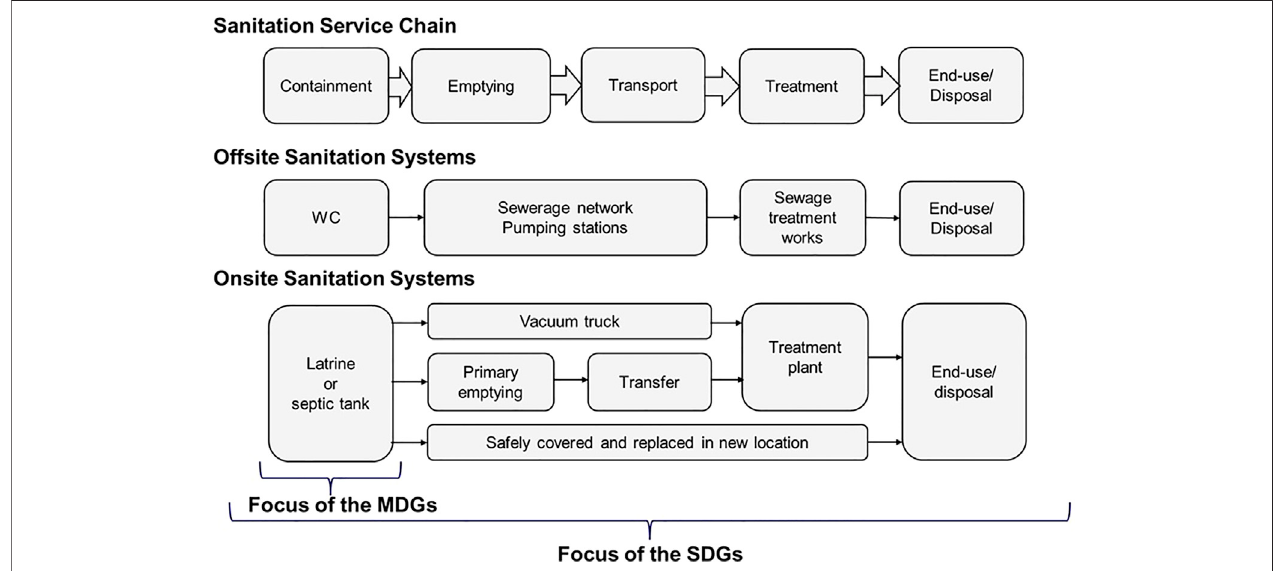
FIGURE 1 | The steps of the sanitation service chain (SSC) chain and examples of these steps in offsite and onsite sanitation systems in relation to the Millennium Development Goals (MDGs) and Sustainable Development Goals (SDGs).